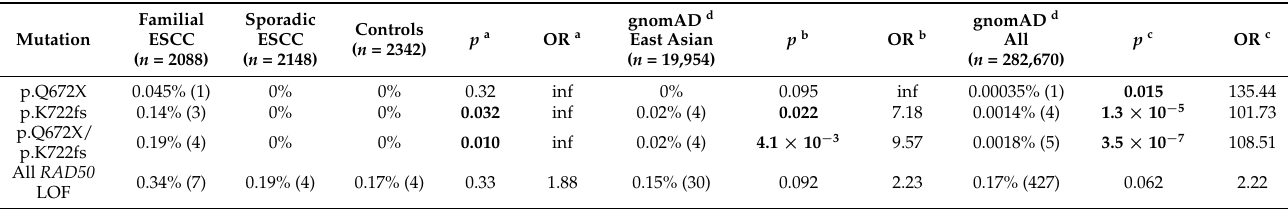
Table 3. Estimated risk of familial ESCC with LOF RAD50 variants in Henan cohort of familial ESCC versus sporadic ESCC and controls, and East Asian population or all populations from